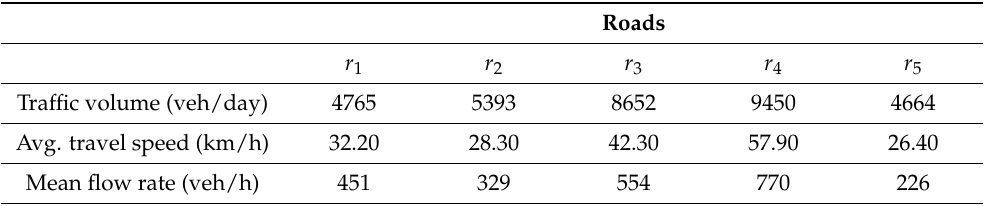
Table 2. Weekly average daily traffic metrics.